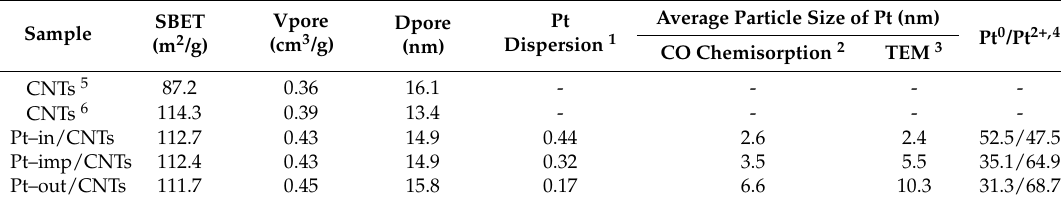
Figure 2. ( a ) N 2 adsorption–desorption isotherms and ( b ) pore size distribution curves of Pt–in/CNTs, Pt–imp/CNTs, Pt–out/CNTs, pristine CNTs, and CNTs by acid treatment. Table 1. Physicochemical properties of CNTs and